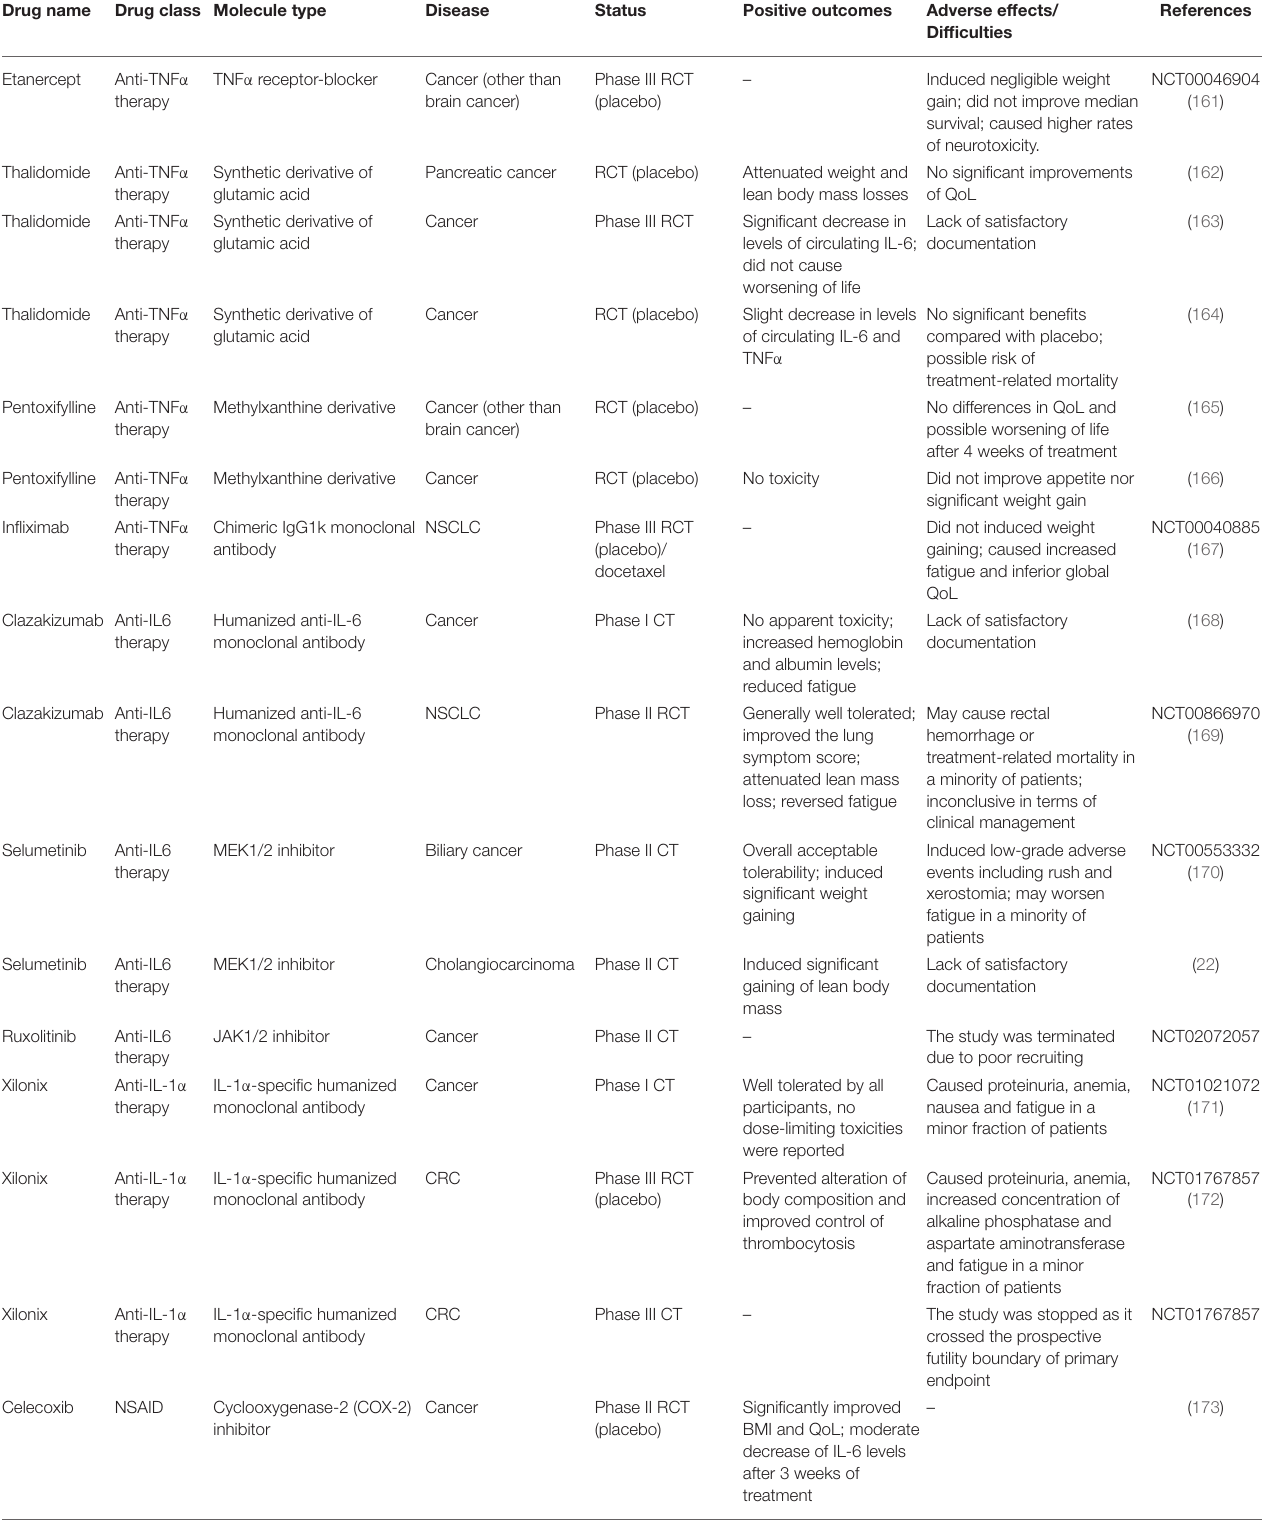
TABLE 1 | Table summarizing unimodal treatment options mentioned in this